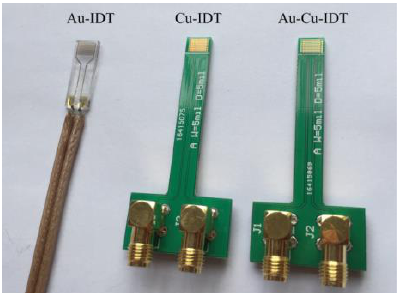
Figure 5. Diagram of three kinds of the planar-interdigitated electrodes (IDT) used. Au-IDT: Au electrode on Si substrate; Cu-IDT: Cu electrode on printed circuit board (PCB) substrate; and Au-Cu-IDT: Au electrode on PCB substrate.